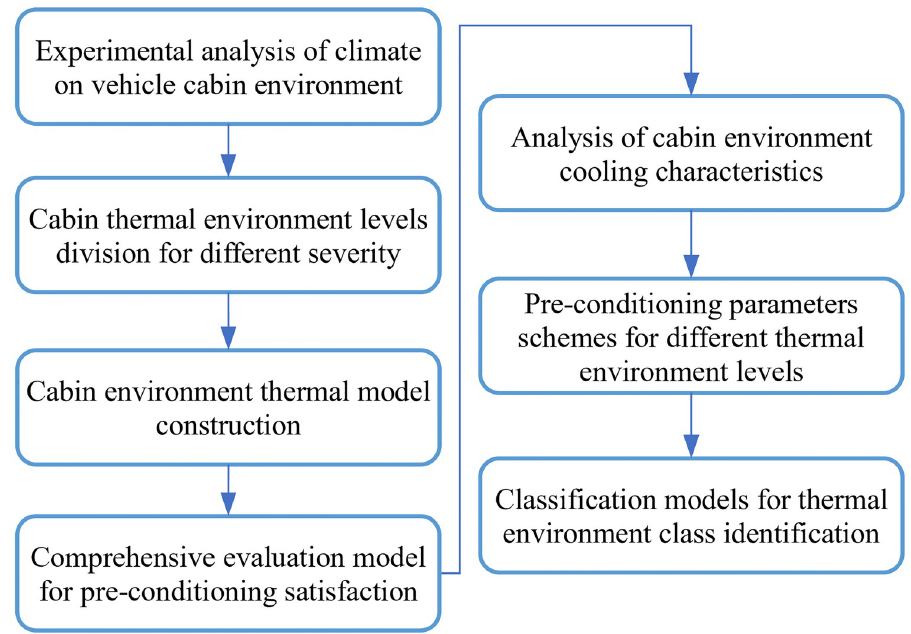
Fig 2. Research method of automobile cabin pre-conditioning. The system levels and classifies thermal environment. The database develops solutions for each thermal environment level. Cabin pre-conditioning invokes solutions based on the identified thermal environment